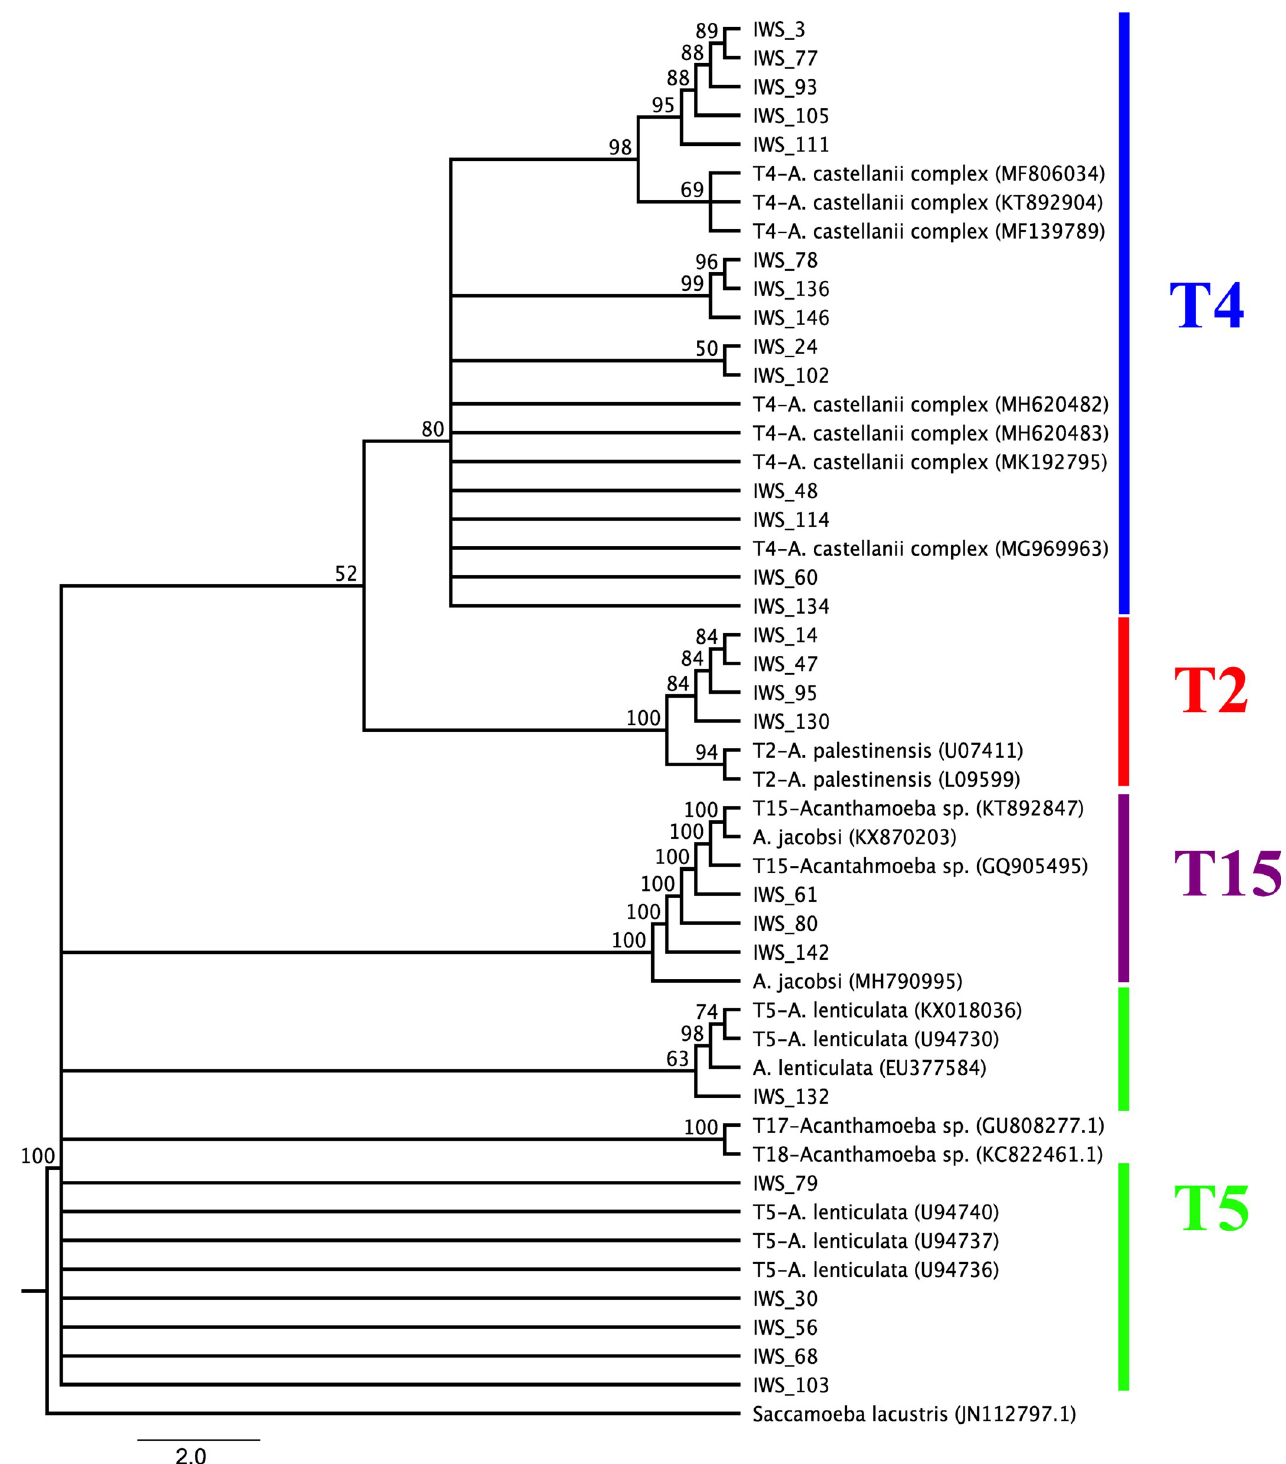
Fig 5. Phylogenetic tree inferred using neighbor-joining models of the 18S rRNA gene DF3 region sequence data for the Acanthamoeba genotypes by MEGA X. Bootstrap values are based on 1000 replicates and the root of the tree evaluated by an outgroup Saccamoeba lacustris .